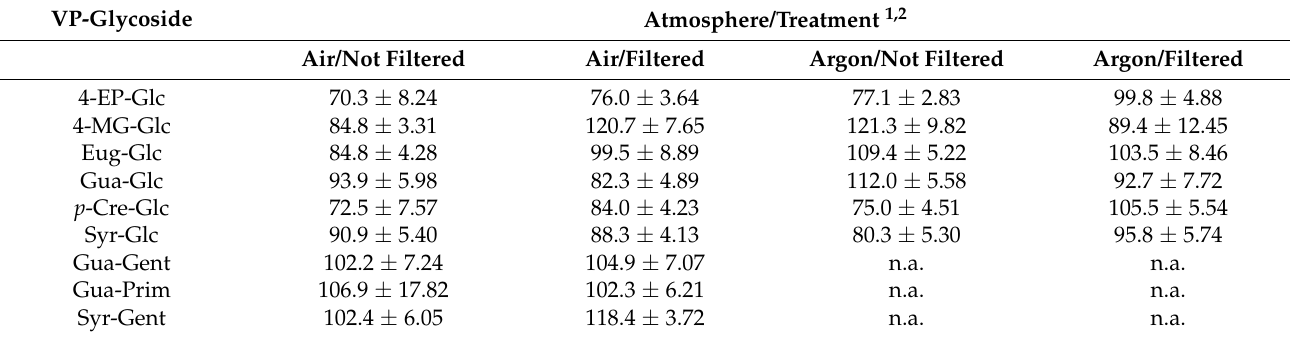
Table 2. Recoveries (%) of intact VP-glycosides from fortified (200 ng/g) Cabernet Franc wines after 12 weeks of sponta- neous